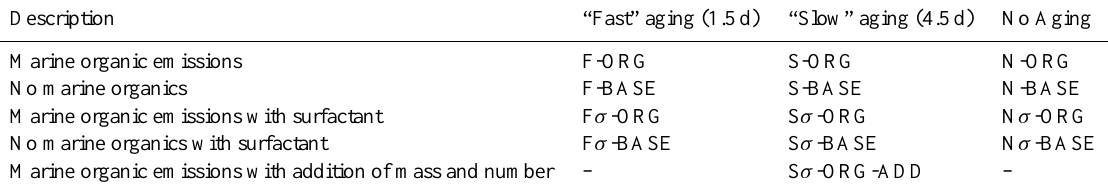
Table 2. Model simulations performed. Description “Fast” aging (1.5d) Marine organic emissions No marine organics F-BASE S-BASE N-BASE F σ -ORG S σ -ORG N σ